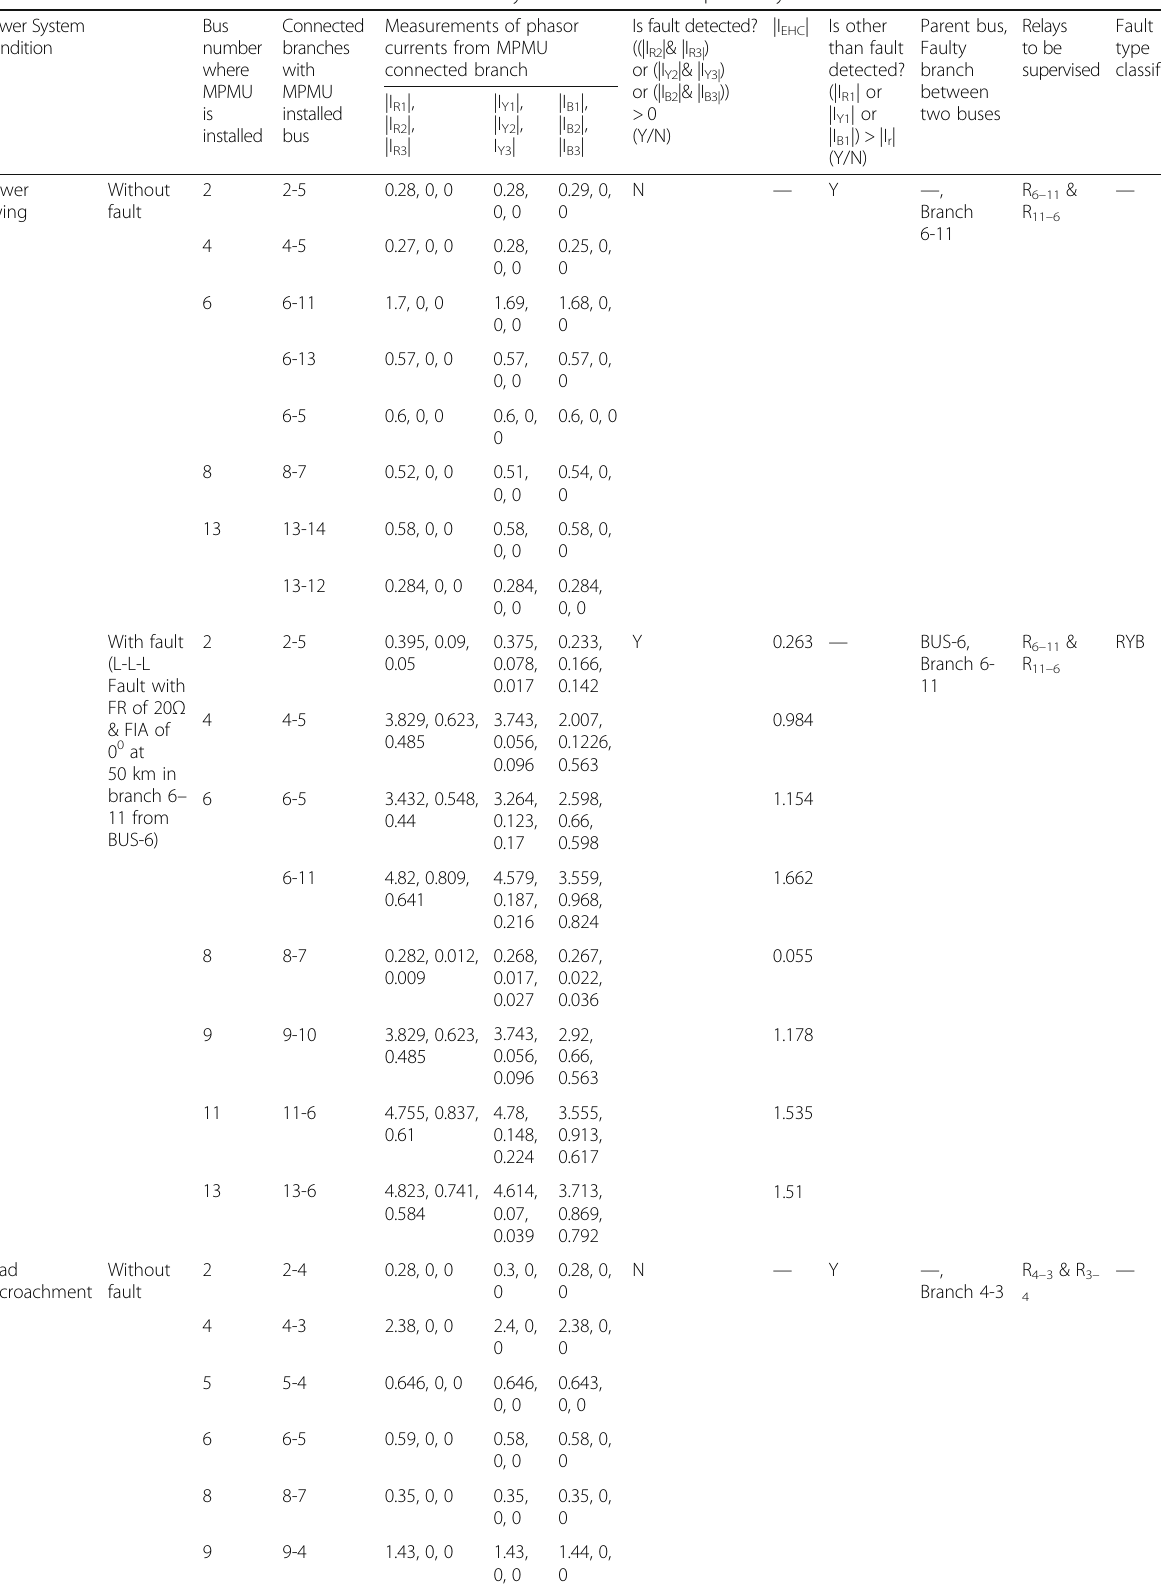
Table 4 Results of case studies conducted in IEEE-14 bus system under various power system conditions Power System